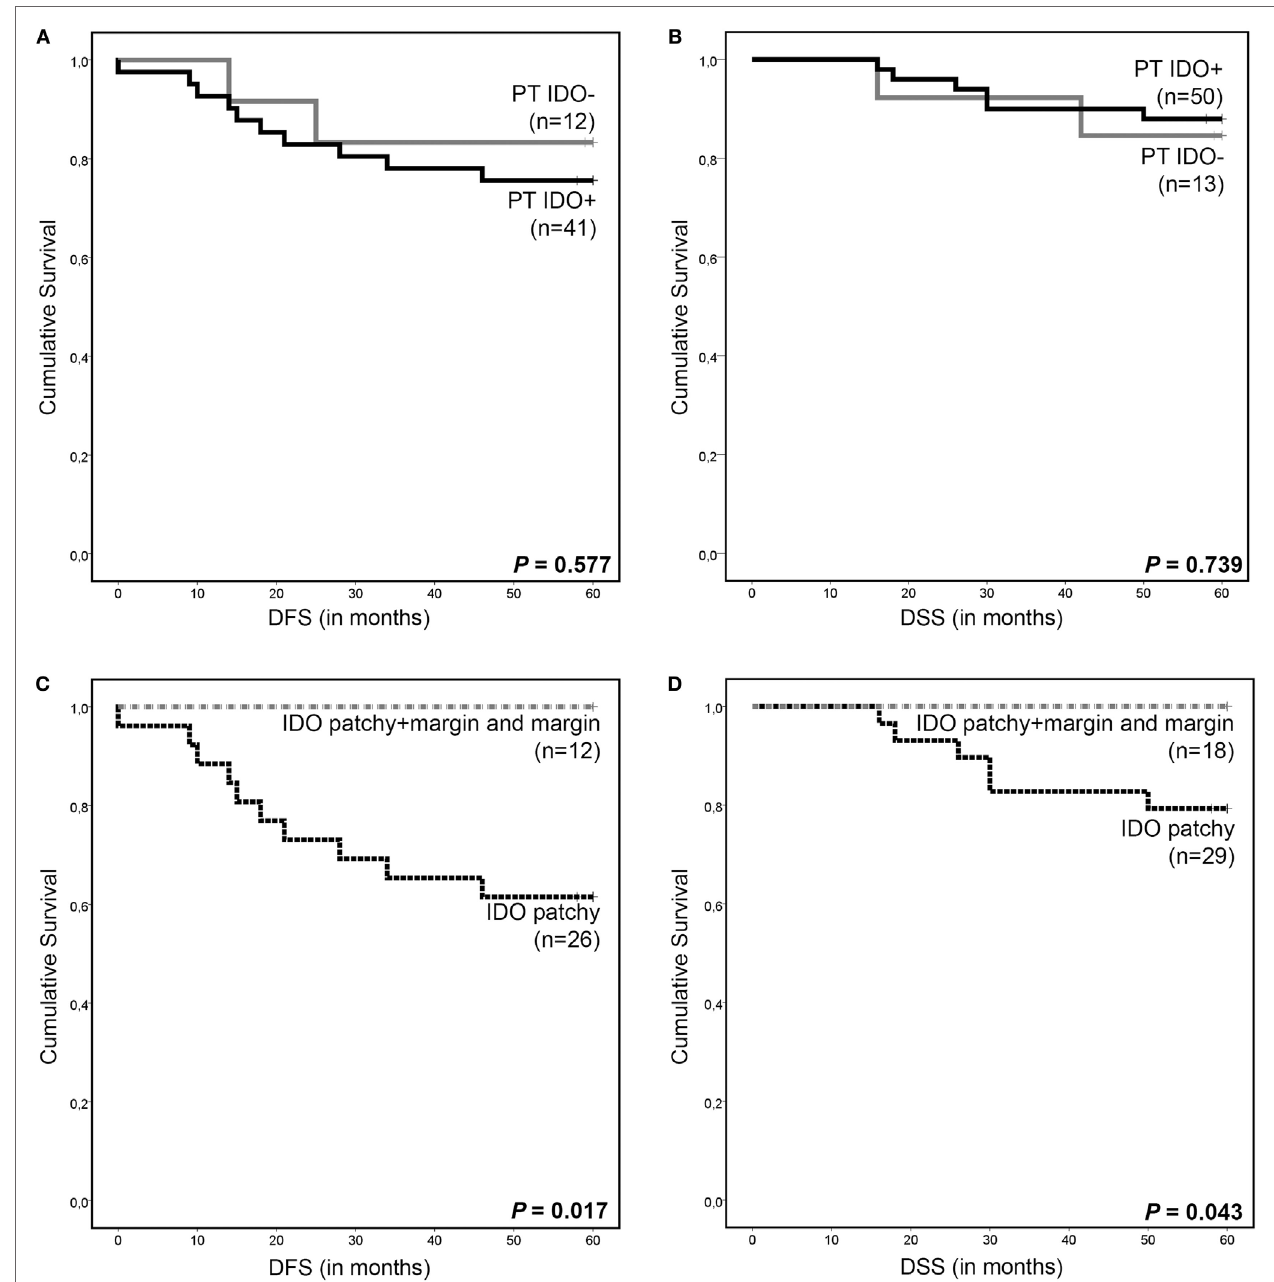
FigUre 4 | Survival analysis according to indoleamine 2,3-dioxygenase (IDO) expression in cervical cancer. Kaplan–Meier 5-year survival curve shows (a) disease-free survival (DFS) and (b) disease-specific survival (DSS) for patients with IDO-positive primary tumors (PT IDO + , black line) and IDO-negative (PTs IDO − , gray line). Kaplan–Meier 5-year survival curves show (c) DFS and (D) DSS for patients with patchy IDO expression (black dotted line), for patients with marginal, including patchy + marginal, IDO expression (gray dotted line) by PT cells. P values were calculated between the different groups using the log-rank test. NB: for some patients, DFS and DSS data are missing due to loss of